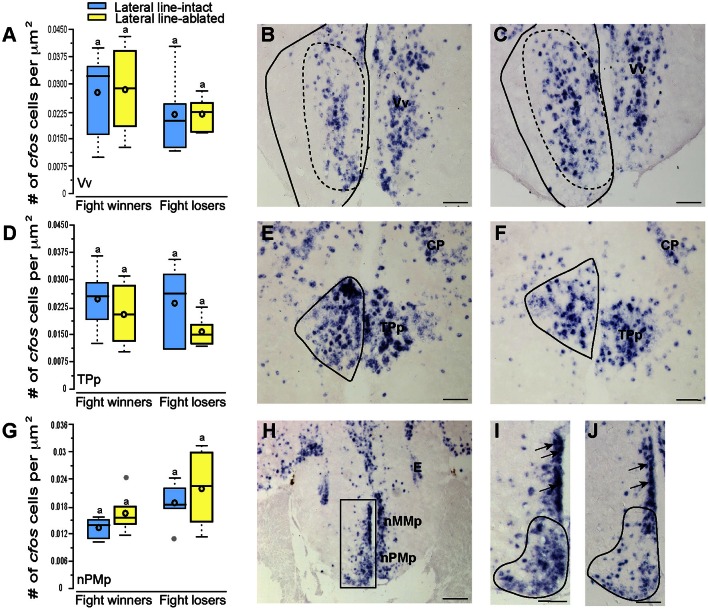
Fight losers have increased activation of the nPMp but other SDMN regions are unaffected. Quantification of cfos staining in the Vv (A), TPp (D), and nPMp (G) in lateral line-intact (blue) and -ablated (yellow) fight winners and losers (N = 5–6 for all groups). Photomicrographs of representative cfos staining (dark blue label) in the Vv of a lateral line-intact (B) and -ablated (C) animal, and the TPp of an intact (E) and ablated (F) animal. The preoptic area was divided into two parts, the nMMp, and the nPMp for quantification (H). Representative photomicrographs in the POA of lateral line-intact fight winner (I) and loser (J). Arrows in (I,J) indicate magnocellular cells quantified as part of the nMMp. Solid circles depict nuclei borders and dashed outlines represent the subarea quantified for each nucleus. If no dashed outline is present, the entire nucleus was quantified. Different letters indicate statistical significance at P < 0.05 using post-hoc LSD tests. Scale bars in (B,C,E,F) represent 25 μm. Scale bars in (H) represents 100 μm and scales in (I,J) represent 12.5 μm. See Figure 1 legend for box plot descriptions. See list for abbreviations.